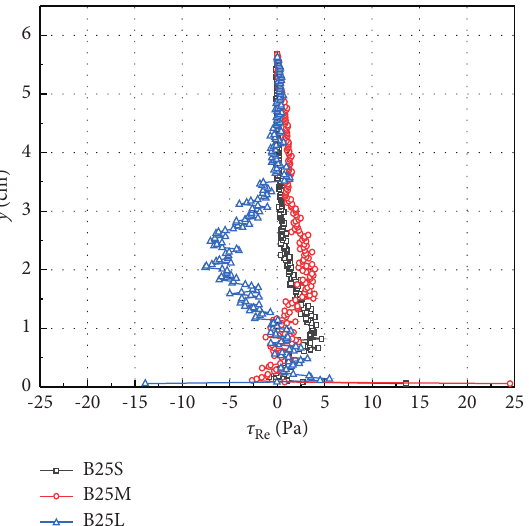
Figure 16: The vertical distribution of Reynolds stress in different working conditions ( x � 2cm).